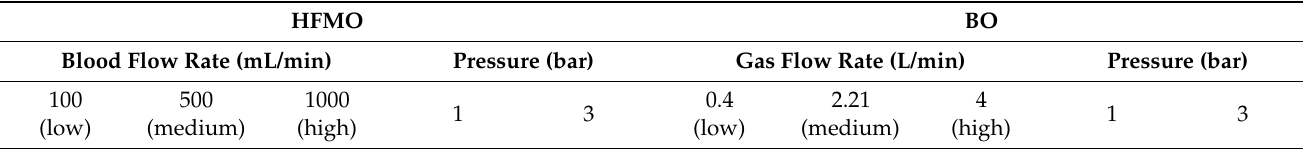
Table 1. Test parameters for the preliminary